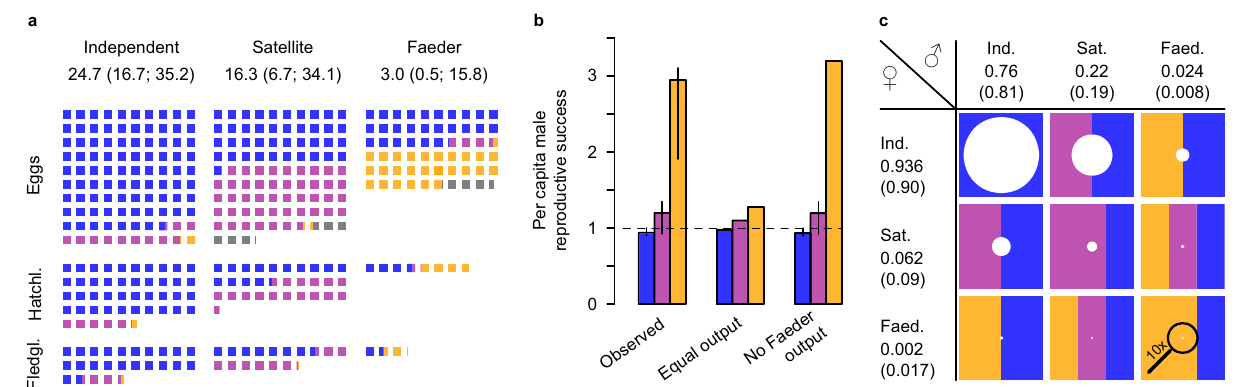
Fig. 3 Fertility rates and reproductive success by morph and sex. a Relative reproductive output for each female morph. Each square represents an offspring and we depict morph output relative to scores of a hundred eggs laid by Independent females. Square color represents the expected offspring morph based on the “ Observed ” model prediction for a stable polymorphism. Numbers indicate the mean (95% CrI) number of fl edglings an individual female would produce. Independents are represented in blue, Satellites in purple, Faeders in orange and homozygous lethal eggs in gray. b Inferred male reproductive success (means and 95% CrI) needed to keep allelic frequencies stable according to three different scenarios of female reproductive output: observed differences in reproductive output for females in captivity ( “ Observed ” ), no differences in reproductive output between morphs ( “ Equal output ” ), and assuming that Faeder females do not produce any fl edglings ( “ No Faeder output ” ). Horizontal broken line refers to equal mean reproductive success across morphs. The models use the posterior distributions ( N = 10,000 simulated values) of annual laying rate, hatching and fl edging success. Source data are provided as a Source Data fi le. c Inferred sex-morph contribution to the next fl edging cohort. The row numbers indicate the proportion of fl edglings in a population produced by each female morph, and column numbers refer to the proportion of fl edglings produced per male morph. In parentheses, the sex- speci fi c adult morph ratios obtained from the wild (calculated from Supplementary Table 3 in ref. 18 ) are given. Each circle area represents the speci fi c fl